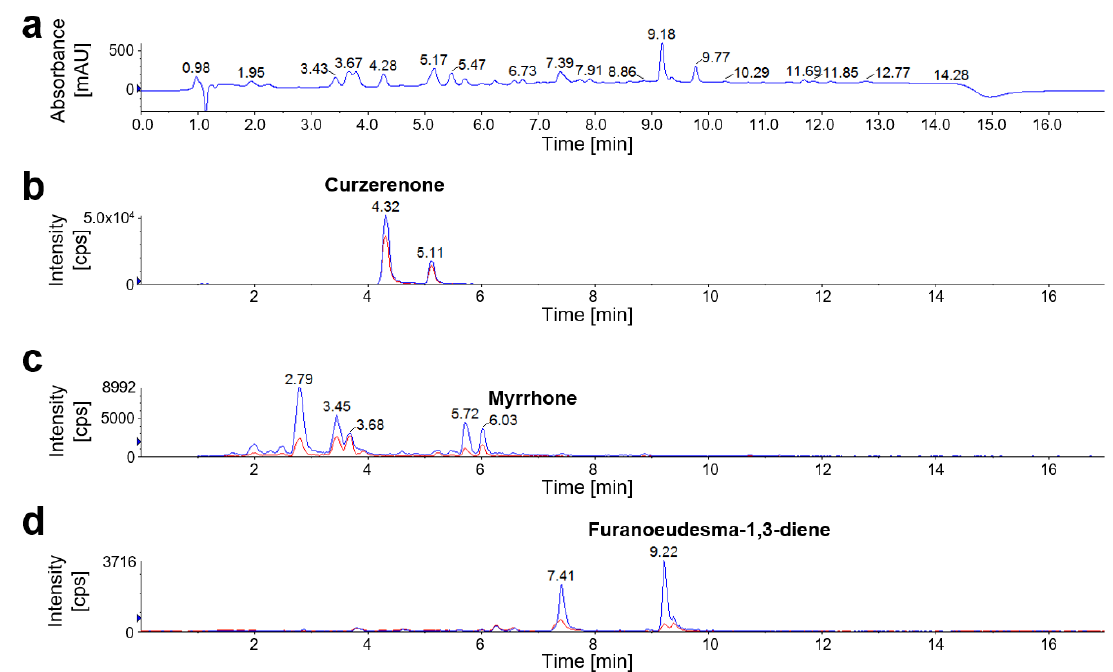
Figure 5. Chromatograms of C. holtziana olegum resin. HPLC-MS/MS analysis revealed the presence of curzerenone, furanoeudsma-1,3-diene, and myrrhone in C. holtziana , but no guggulsterones. ( a ) Total wavelength chromatogram (TWC) with detection at 210 nm, 254 nm, and 280 nm. ( b ) Multiple reaction monitoring (MRM) chromatogram of curzerenone ( t R = 4.32 min) with m / z 231.0/83.0 as quantifier (blue) and m / z 231.0/149.0 as qualifier (red). ( c ) MRM chromatogram of myrrhone ( t R = 6.03 min) with m / z 229.0/159.0 as quantifier (blue) and m / z 229.0/187.2 as qualifier (red). ( d ) MRM chromatogram of furanoeudesma-1,3-diene ( t R = 9.22 min) with m / z 215.0/119.1 as quantifier (blue) and m / z 215.0/105.2 as qualifier (red).